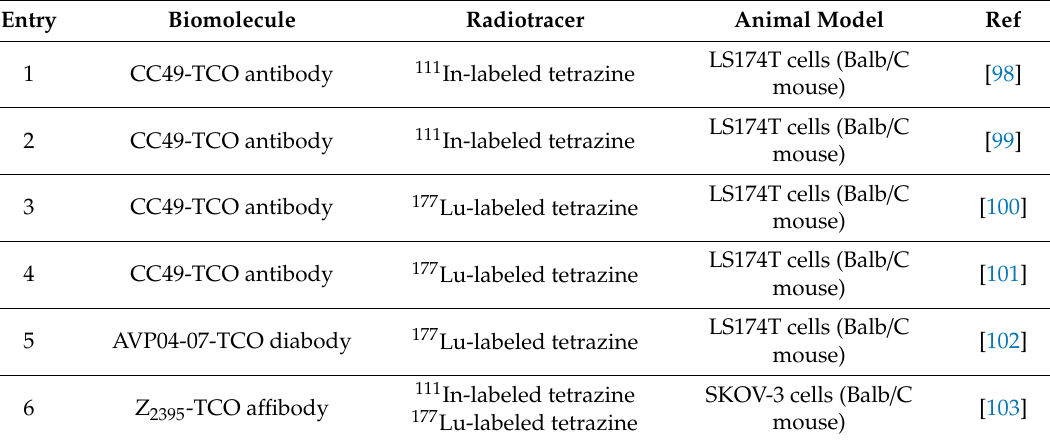
Figure 13. General strategy for pre-targeted imaging and therapy using IEDDA. Table 3. IEDDA-based in vivo pre-targeted approach.